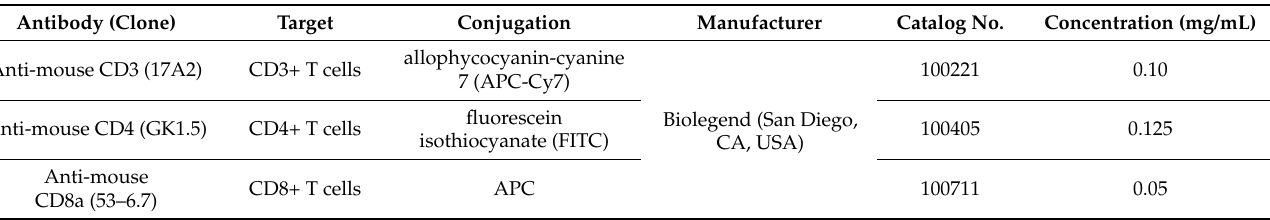
Table 1. Antibody panel used for FACS